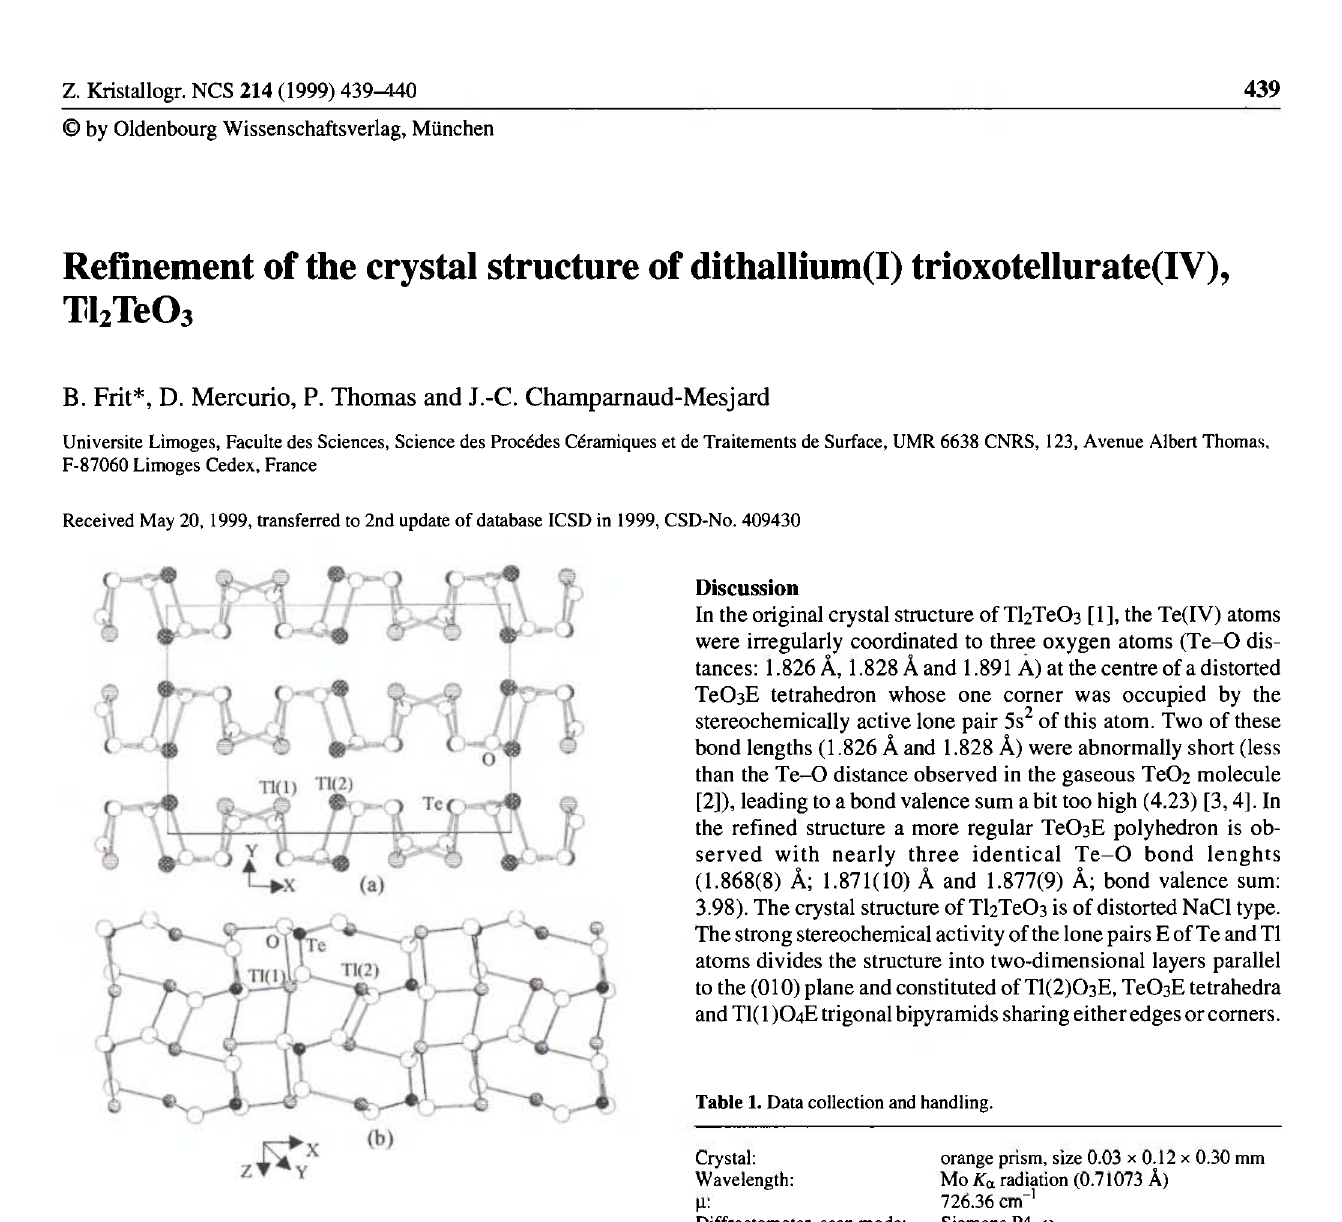
Table 1. Data collection and handling.